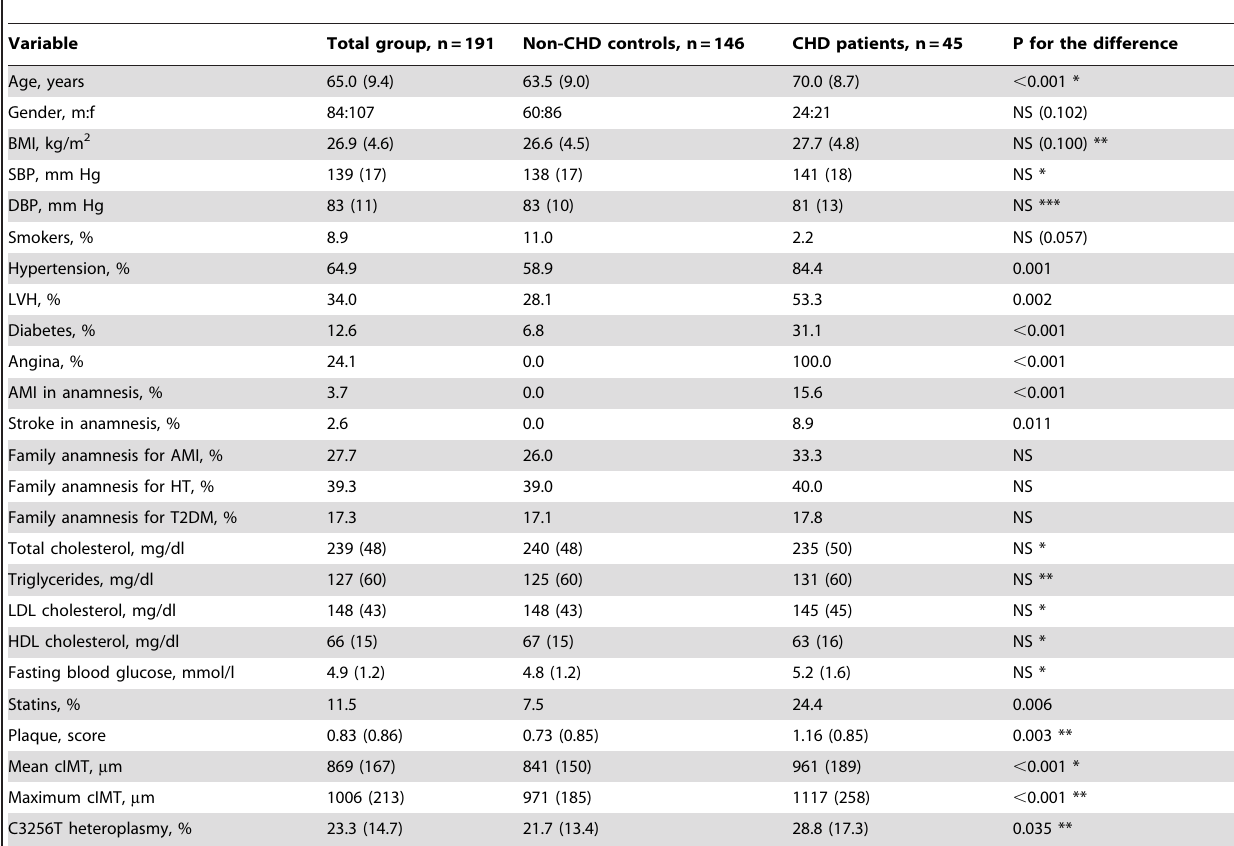
Table 1. Antropometric, clinical and biochemical data of study